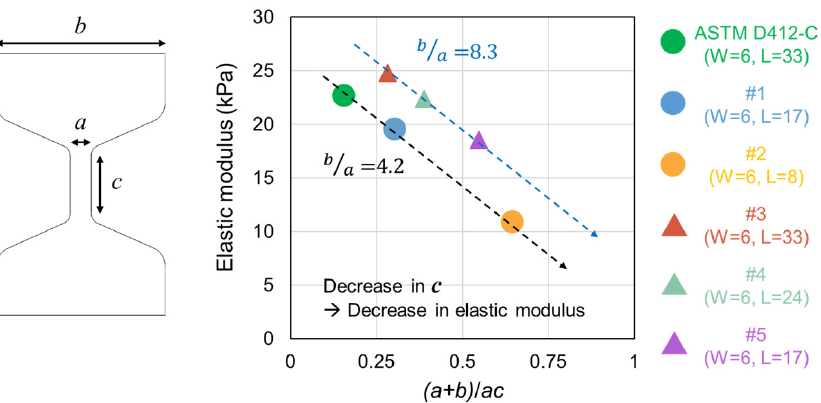
Figure 3. Elastic modulus value of hydrogels with a different gauge length and width, represented along ( a + b )/ ac .